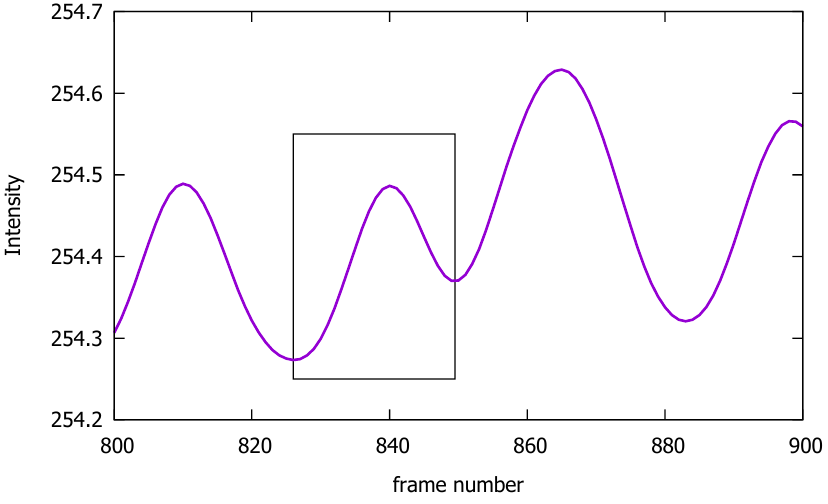
Figure 5. Schematic diagram representing a random frame window used to calculate the AC and DC components of the